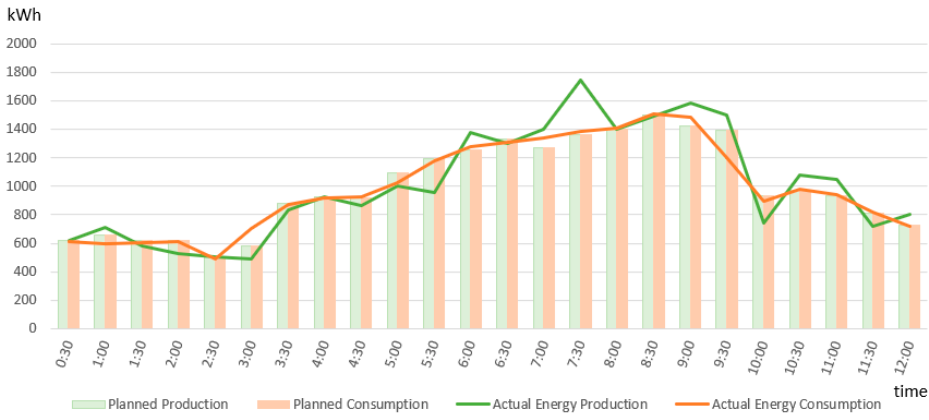
Figure 8. BRP’s total planed vs actual energy consumption. Sensors 2019 , 19 , x